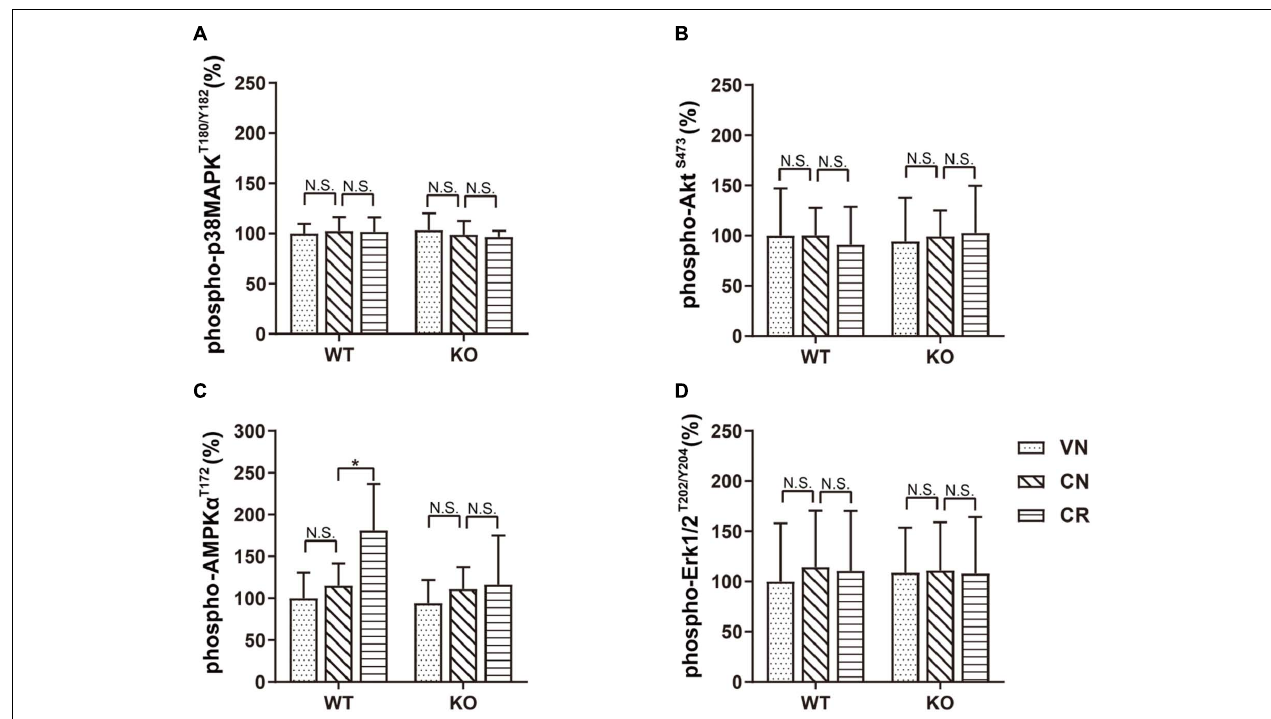
FIGURE 4 | Voluntary exercise selectively activates the AMPK pathway through adiponectin. Levels of phospho-p38MAPK T180 / Y182 , phospho-AKT S473 , phospho-AMPK T172 , and phospho-Erk1/2 T202 / Y204 following various treatments were quantified by ELISA. (A–D) In both strains, COR and exercise did not affect the expression of phospho-p38MAPK T180 / Y182 (A) , phospho-AKT S473 (B) , or phospho-Erk1/2 T202 / Y204 (D) . However, exercise significantly raised the phospho-AMPK T172 level in stressed WT, but not ADN-KO mice (C) . Data are shown as means ± SD. n = 10 mice/group. * p < 0.05 by two-way ANOVA and Tukey’s post hoc test. N.S., non-significant; MAPK, mitogen-activated protein kinase; AKT, protein kinase B; AMPK, AMP-activated protein kinase; Erk, extracellular signal-regulated